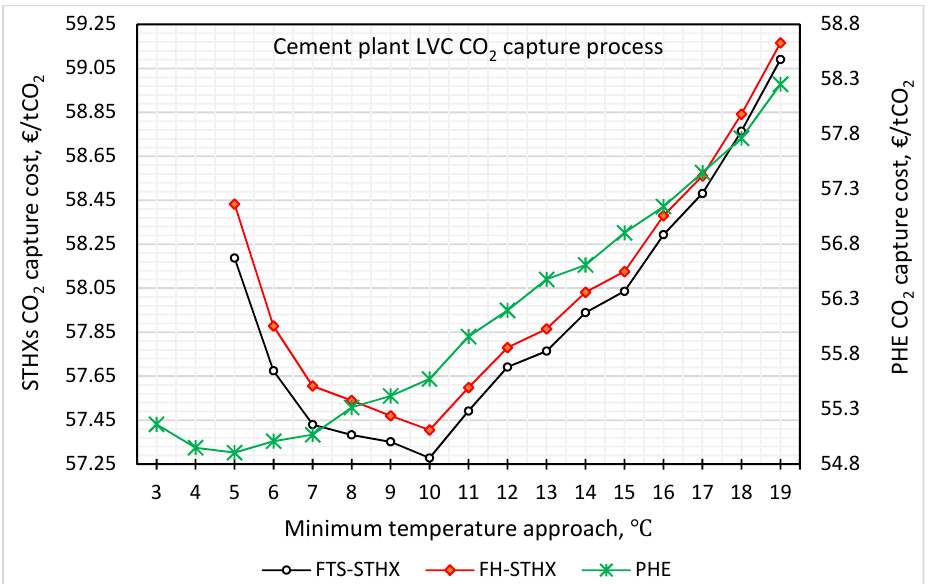
Figure 10. Energy and heat exchanger costs trade-off analysis at different ∆ T min for different heat exchanger types in an LVC CO 2 capture from cement flue gas.